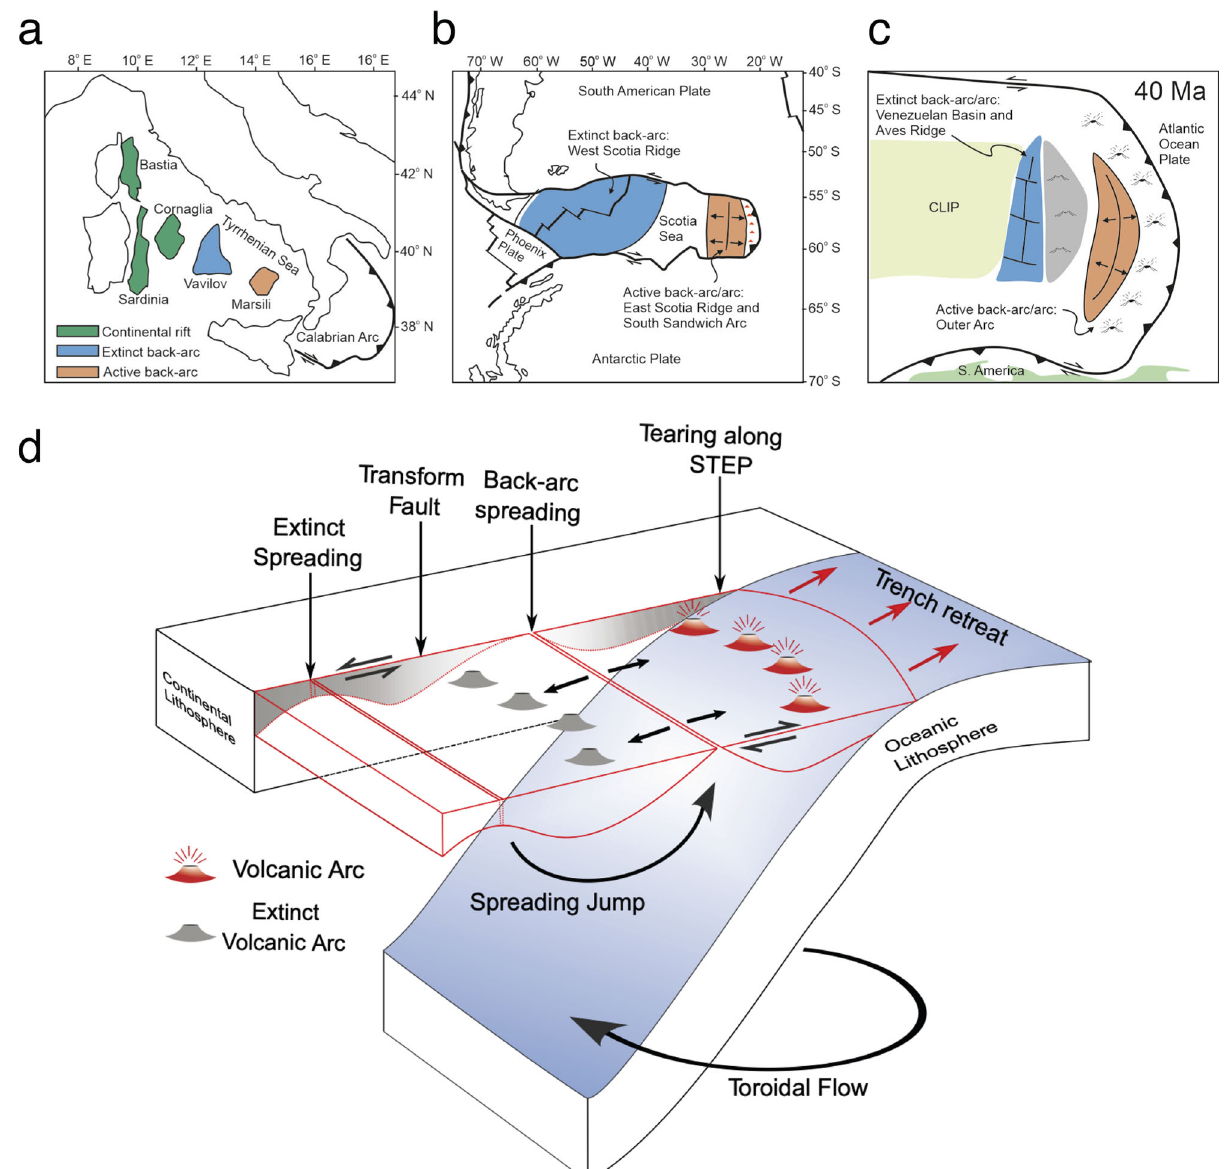
Fig. 1 Mechanism sketch. a – c Extinct and active back-arc spreading centre in the narrow Tyrrhenian Sea (adapted from Gueydan et al. 33 ), Scotia (adapted from Eagles & Jokat 18 , and Lesser Antilles at ~40 Ma (adapted from Allen et al. 19 . All subduction zones retreat within the bounds of STEP- or similar transform faults. d Sketch of a spreading centre jump in a retreating subduction zone, bound laterally by transform faults. The subducting slab tears along STEP (subduction-transform-edge-propagator) faults, whereas the back-arc moves relative to the neighbouring along transform faults (grey shaded regions). Within a short period is old spreading centre and the associate volcanic arc extinct, and a new spreading centre forms closer to the retreating